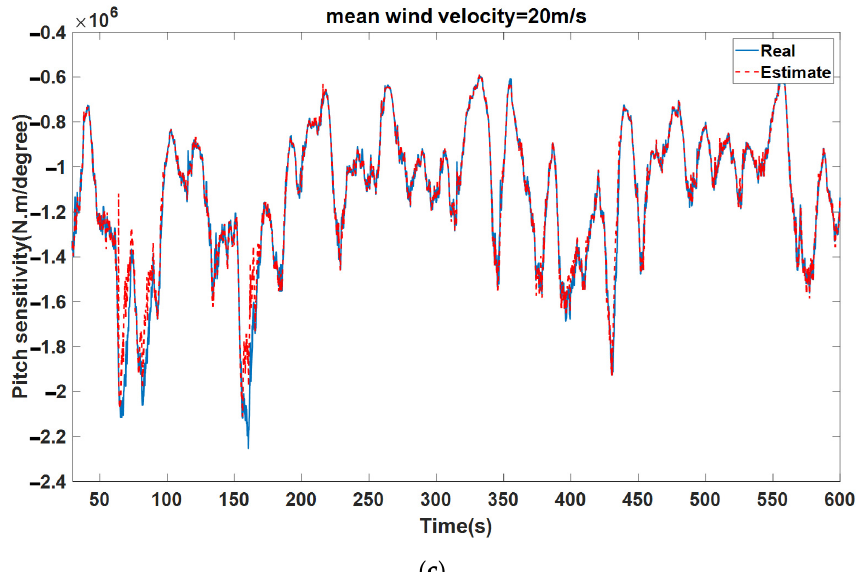
Figure 11. Pitch sensitivity estimation in different mean wind speed values by using the ANFIS system. ( a ) 18 m/s. ( b ) 19 m/s. ( c ) 20 m/s.